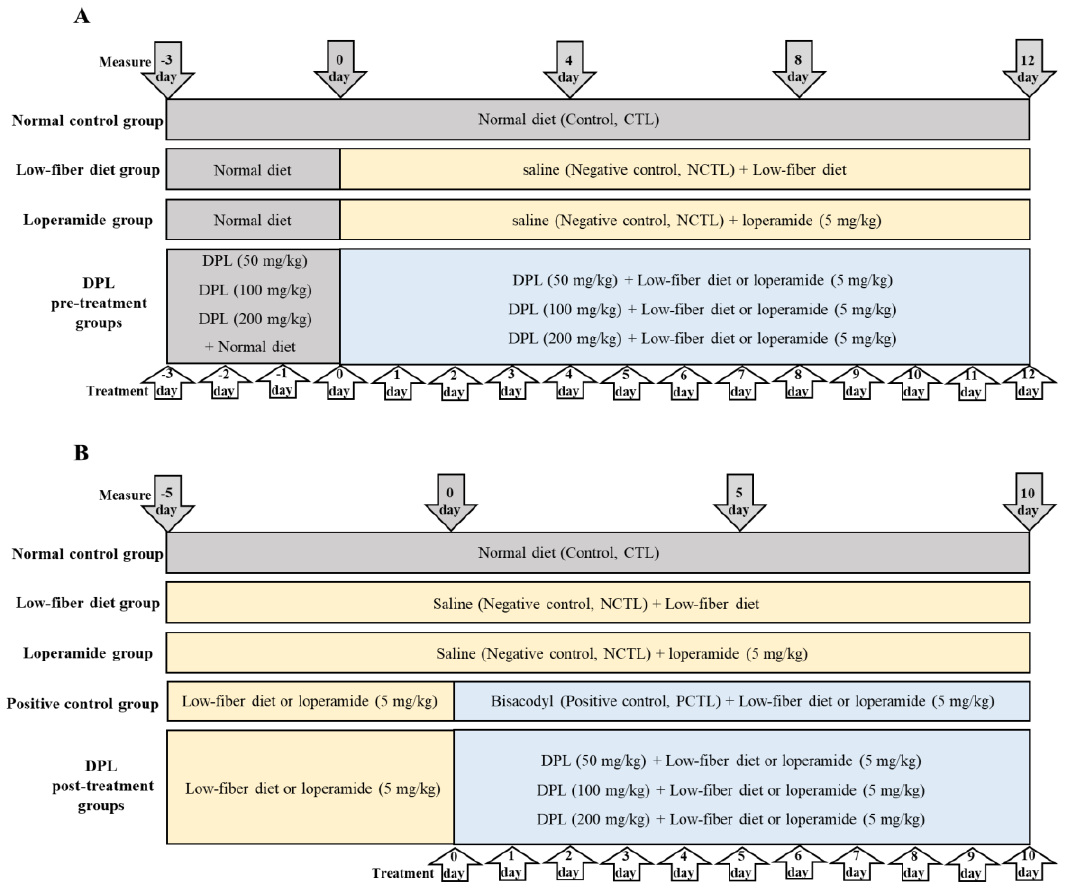
Figure 1. The scheme of the D. morbiferus H. Lév. leaf extract (DPL) (50, 100, and 200 mg/kg) laxative experiment. The extracts and physiological saline solution were administered once a day during the experiment. ( A ) DPL was pretreated for three days before administration of a low-fiber diet or loperamide, followed by administration for twelve days. ( B ) The therapeutic effect of constipation by post-treatment with DPL. After five days of low-fiber diet or loperamide administration, three different doses of DPL and bisacodyl (0.25 mg/kg), as a positive control (PCTL), were administered.